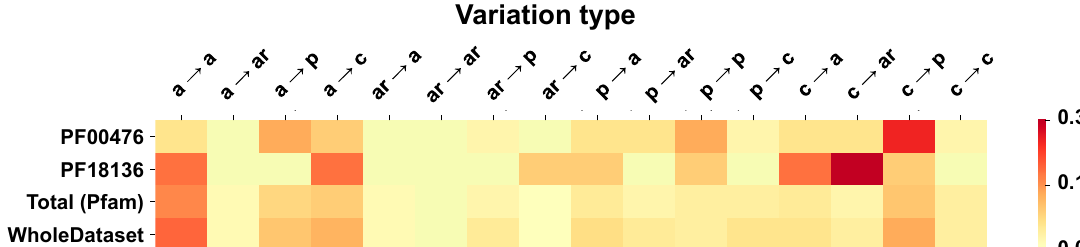
Figure 7. The heatmap shows the frequency of occurrence of each disease related variation type in each of the two Pfam domains of the DNA polymerase subunit gamma-1 (P54098 (DPOG1_HUMAN). The color span from yellow (low frequency) to red (high frequency). Kullback–Leibler divergence between distributions of the two Pfams domains is 2.5 bits.